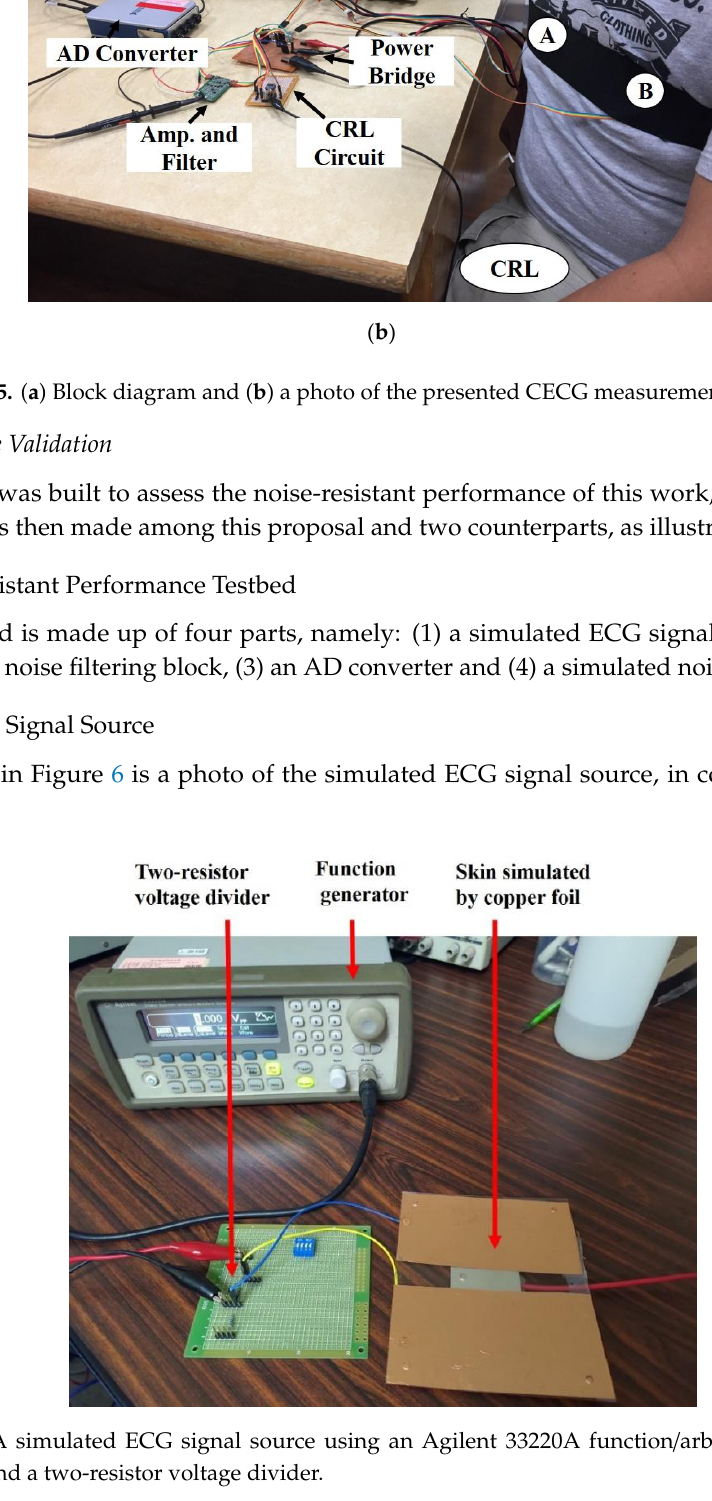
Figure 6. A simulated ECG signal source using an Agilent 33220A function/arbitrary waveform generator and a two-resistor voltage divider.